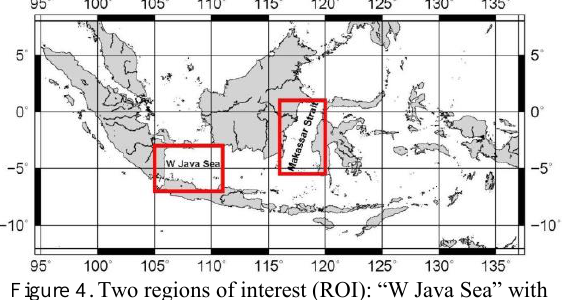
Figure 4. Two regions of interest (ROI): “W Java Sea” with borders 105.0°E / 111.0°E and 7.0°S / 3.0°S, and “Makassar Strait” with borders 116.0°E /120.0°E and 5.5°S / 1.0°N.